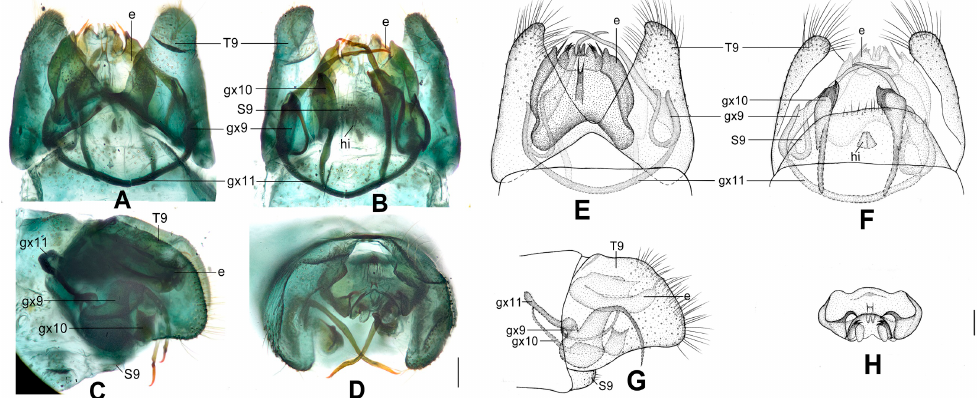
Figure 9. Dilar nujianganus sp. nov. ( A – D ) male holotype, genitalia, photographs: ( A ) dorsal view; ( B ) ventral view; ( C ) lateral view; ( D ) caudal view. ( E – H ) male holotype, genitalia, line drawings: ( E ) dorsal view; ( F ) ventral view; ( G ) lateral view; ( H ) ectoproct, caudal view. e: ectoproct; gx9: